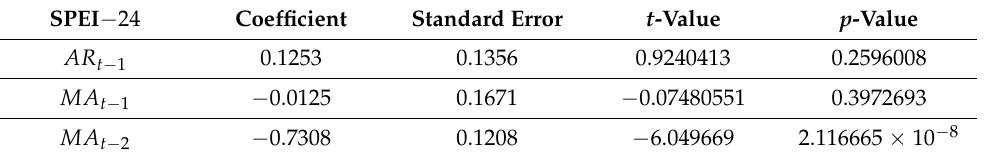
Table 13. SPEI-24 ARIMA (0,1,0)(1,0,2) for seasonal. SPEI −